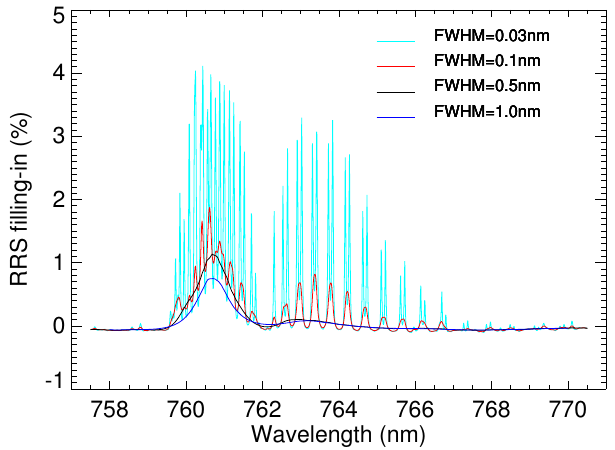
Fig. 11. Similar to Fig. 4 but SZA=70 ◦ .